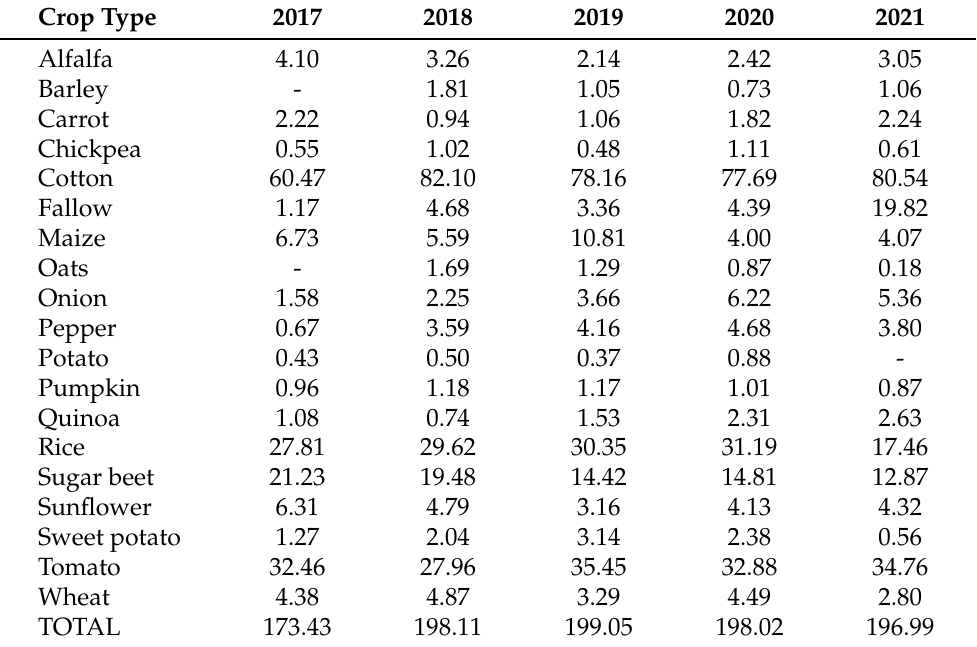
Table 1. Total area (km 2 ) occupied by each crop every year.